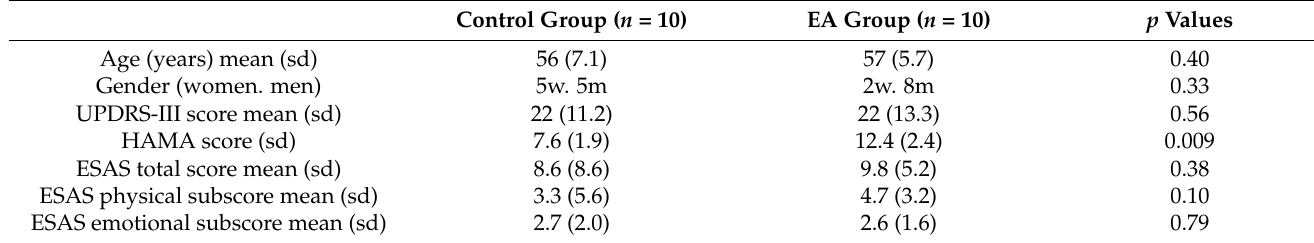
Table 1. Description of population of the